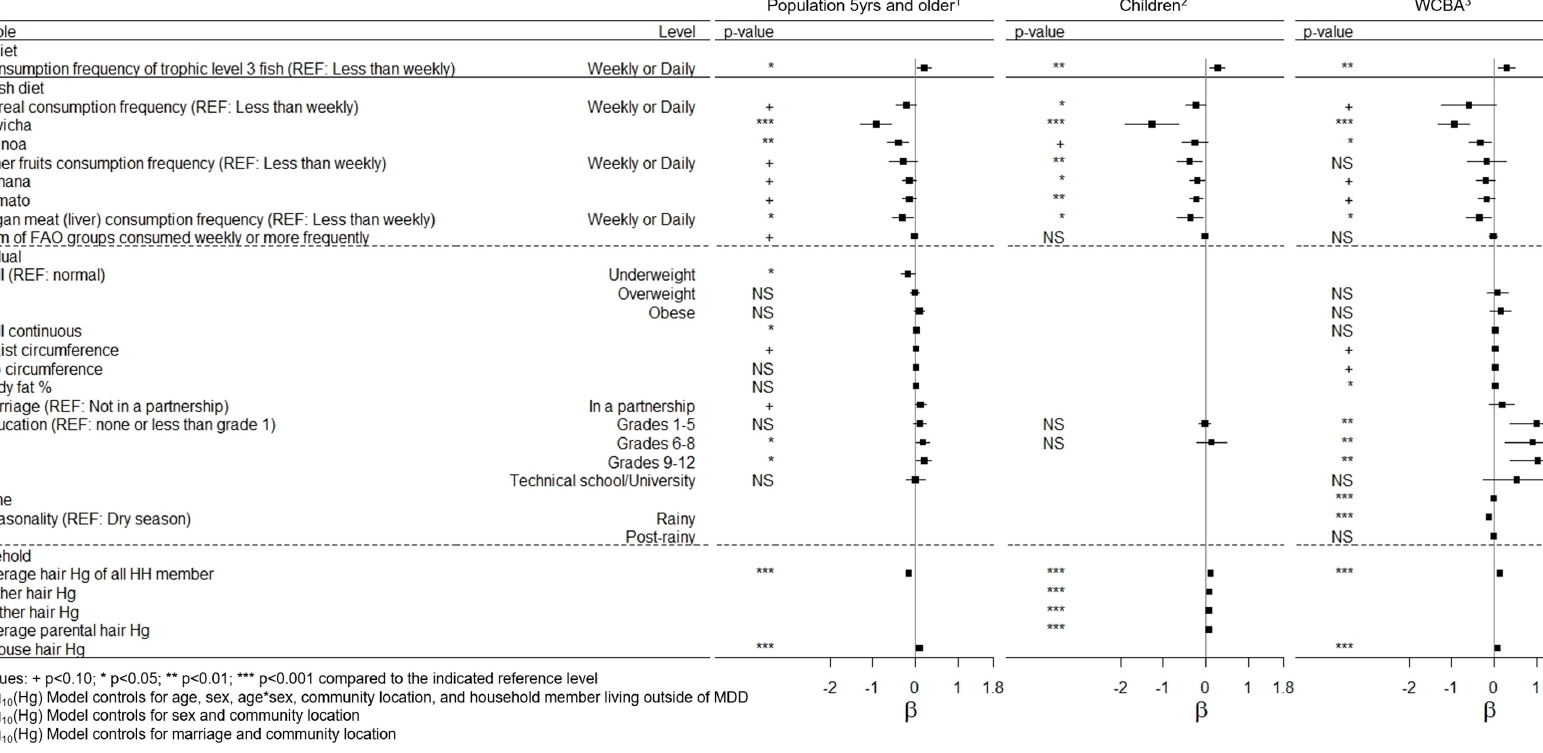
Figure 3. Association between hair mercury and dietary, individual, and household factors in the population five years and older, children, and women of child bearing age (WCBA).